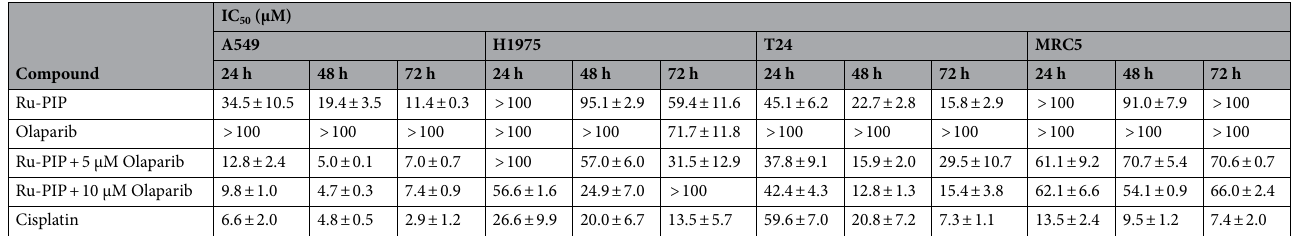
Table 1. Half maximal inhibitory concentration (IC 50 ) values of Ru-PIP, Olaparib, Ru-PIP/Olaparib and cisplatin upon 24, 48 and 72 h treatment in A549, H1975, T24 and MCR5 cells. 100 μM is the maximum concentration tested. Mean ± SD of three independent